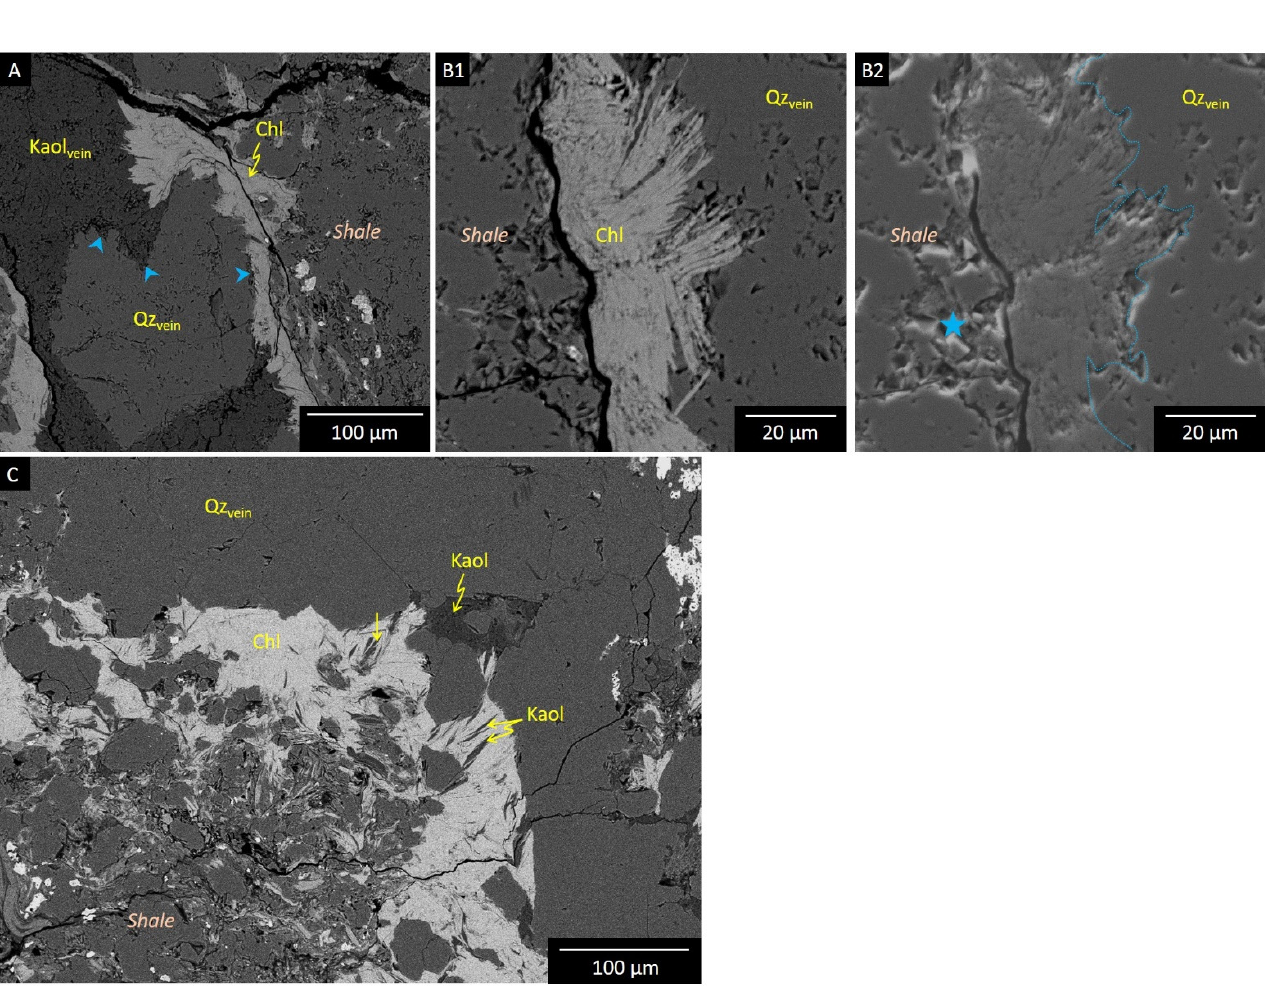
Figure 7. SEM images of veins/shale contacts. ( A ): backscattered-electron image of an euhedral quartz with cracked surfaces surrounded in part by a chlorite fringe. The cracks on the quartz crytsal surfaces are highlighted by blue arrows and are filled by kaolinite. The chlorite grows is stopped by the quartz, but progresses in the kaolinite. ( B1 , B2 ): backscattered and secondary electron images, respectively, of chlorite growing at the expense of the kaolinite nestled in quartz cracks. Kaolinite is no longer visible, but the cracks, whose limits are underlined by a blue dashed line on SE image, contain the neoformed chlorite. The blue star notifies in SE image an example of cracked area in quartz. ( C ): a rare–large–area where the chlorite has almost completely replaced kaolinite (noted residual kaolinite in chlorite fringe), surronding, bypassing or following the euhedral quartz. Qz: quartz; Kaol: kaolinite; Chl: chlorite.